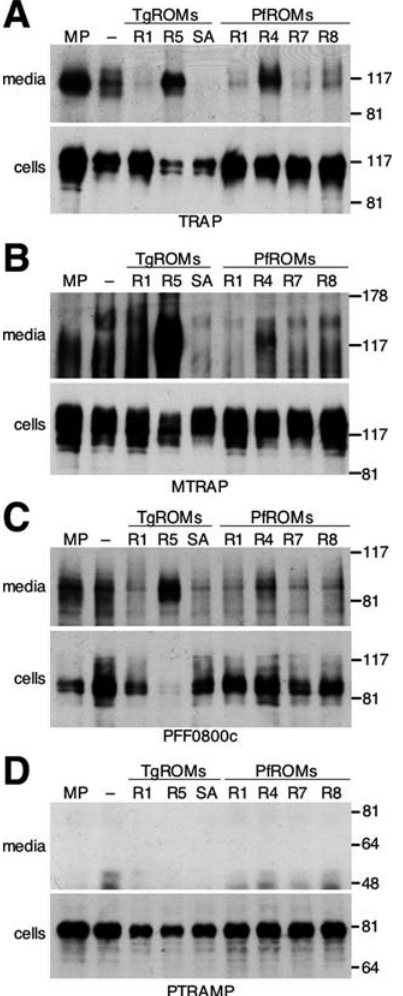
Figure 7. Cleavage of TRAP Adhesins by Parasite Rhomboid Enzymes GFP-tagged full-length TRAP (A), full-length MTRAP (B), truncated PFF0800c (C), and full-length PTRAMP (D) were co-transfected with each rhomboid, and conditioned media was analyzed by anti-GFP Western. Molecular weight standards in kDa are denoted to the right of each panel. DOI: 10.1371/journal.ppat.0020113.g007